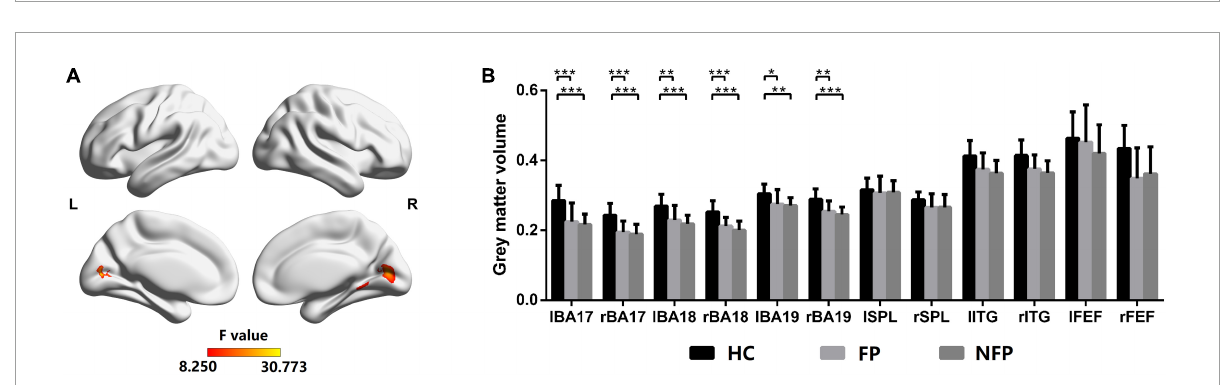
FIGURE3 Comparison of GMVs of participants in the FP, NFP, and HC groups. (A) The significant differences in GMV across brain areas in participants in the three groups ( F -values). (B) Comparison of GMVs in Brodmann areas 17, 18, and 19 and in the SPL, ITG, and FEF areas between participants in the three groups. HC, healthy control; FP, form perception; NFP, no form perception; lBA, left Brodmann area; rBA, right Brodmann area; lSPL, left superior parietal lobule; rSPL, right superior parietal lobule; lITG, left inferior temporal gyrus; rITG, right inferior temporal gyrus; lFEF, left frontal eye field; rFEF, right frontal eye field. *** P_adj < 0.001, ** P_adj < 0.01, and * P_adj <